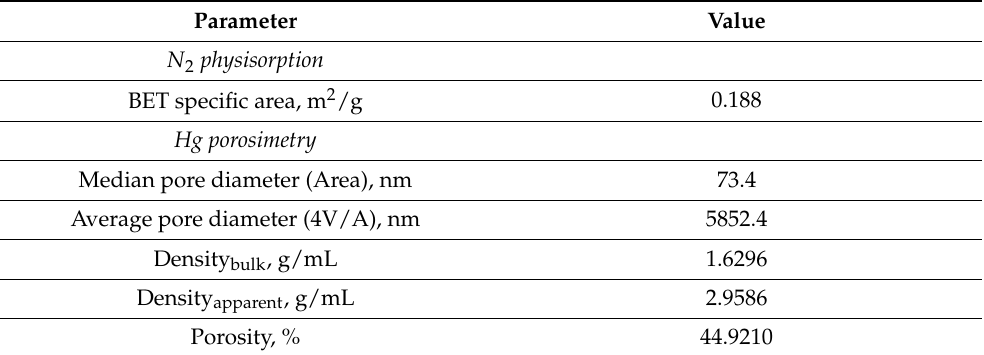
Figure 5. Pore size distribution of volcanic material (black sand), ( a ) determined by Hg porosimetry and ( b ) determined by N 2 physisorption. Table 1. Characterisation of volcanic material (black sand).